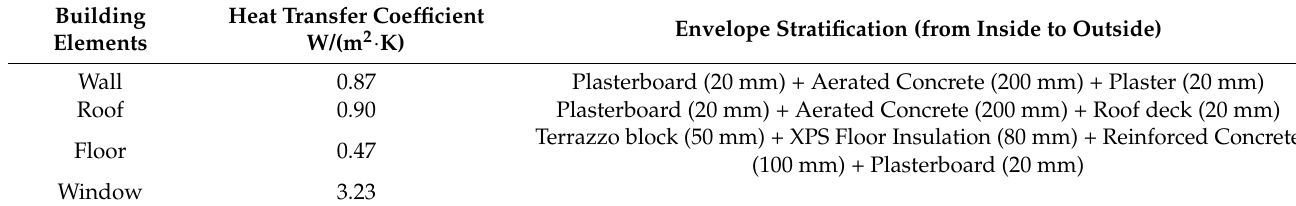
Table 9. Envelope and thermal properties of the simulated building.